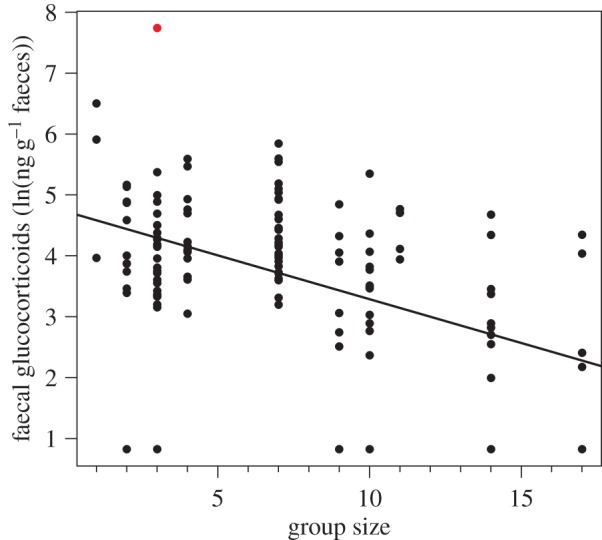
Faecal glucocorticoid levels decreased with increasing size of the social group. Dots represent ln-transformed data and the line is the model prediction after correcting for random effects of group and individual. The results were qualitatively the same when omitting the outlier (in red). Sample size: N = 140 samples from 52 individuals.